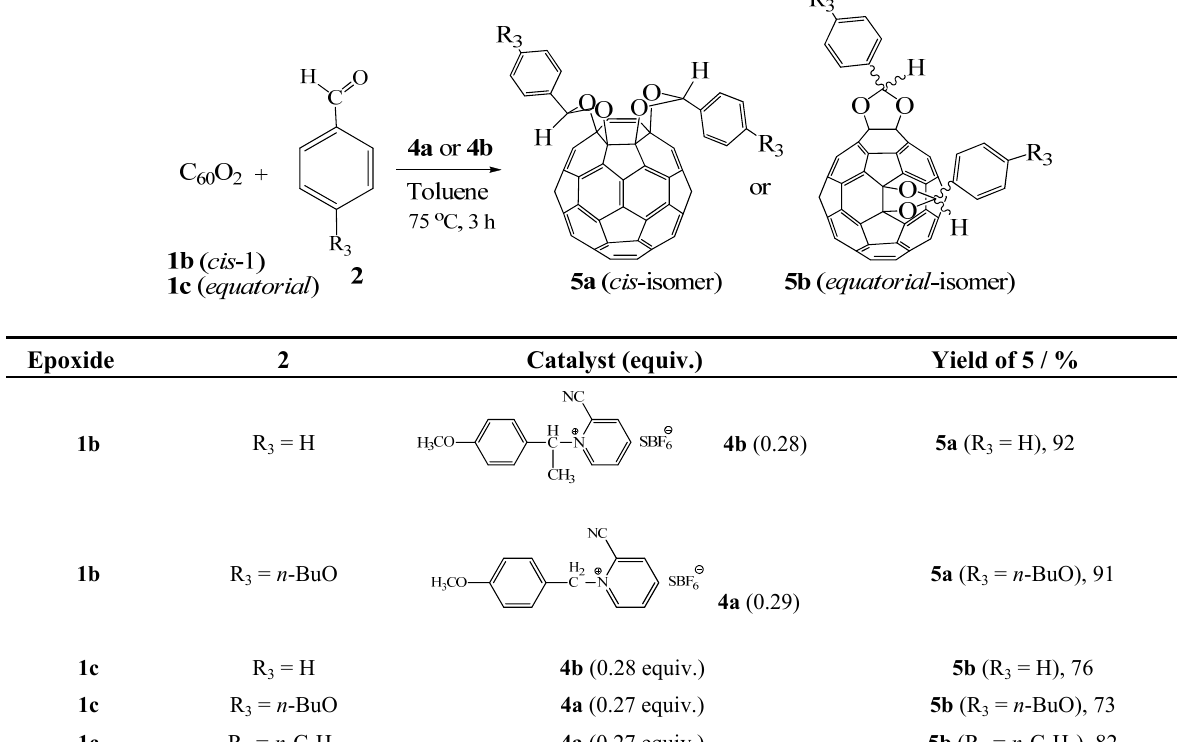
Table 3. Acetalization of fullerene epoxide 1b or 1c with benzaldehyde derivatives 2 in the presence of pyridinium salt 4a or 4b shown in Table